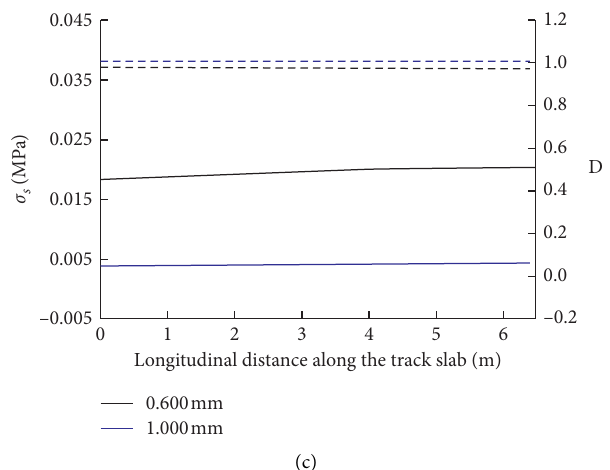
Figure 9: Distribution of σ s and D on the track slab. (a) Undamage stage. (b) Partial damage stage. (c) Complete damage stage.